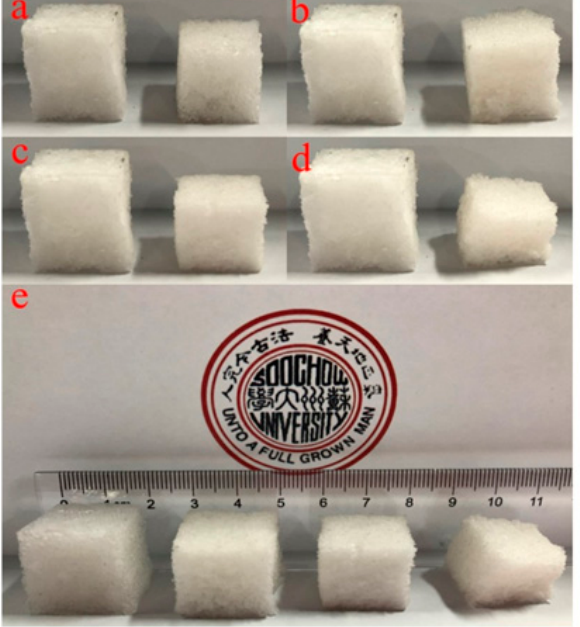
Figure A1. The images of the PDMS sponge with different mass fraction of CAM. ( a ) m PDMS :m CAM = ( b ) m PDMS :m CAM = 1:5, ( c ) m PDMS :m CAM = 1:7, ( d ) m PDMS :m CAM = 1:9, ( e ) the images of